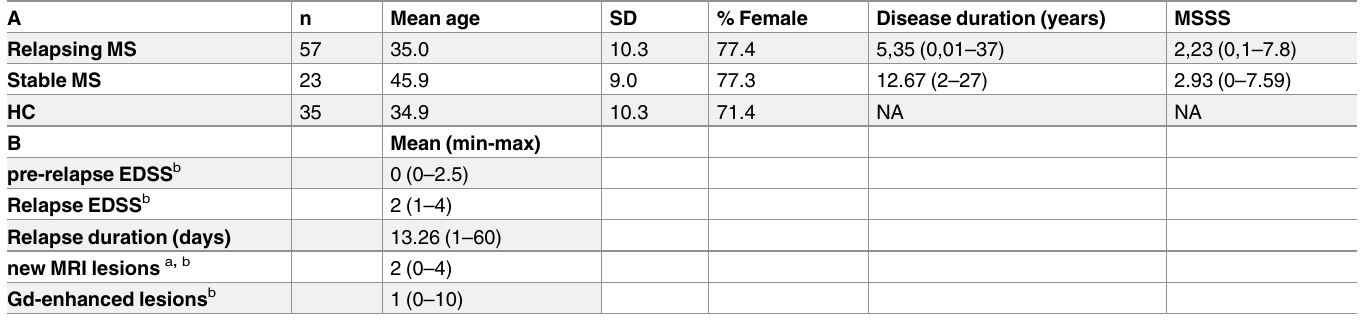
Table 1. Main demographic features of MS patients and healthy control